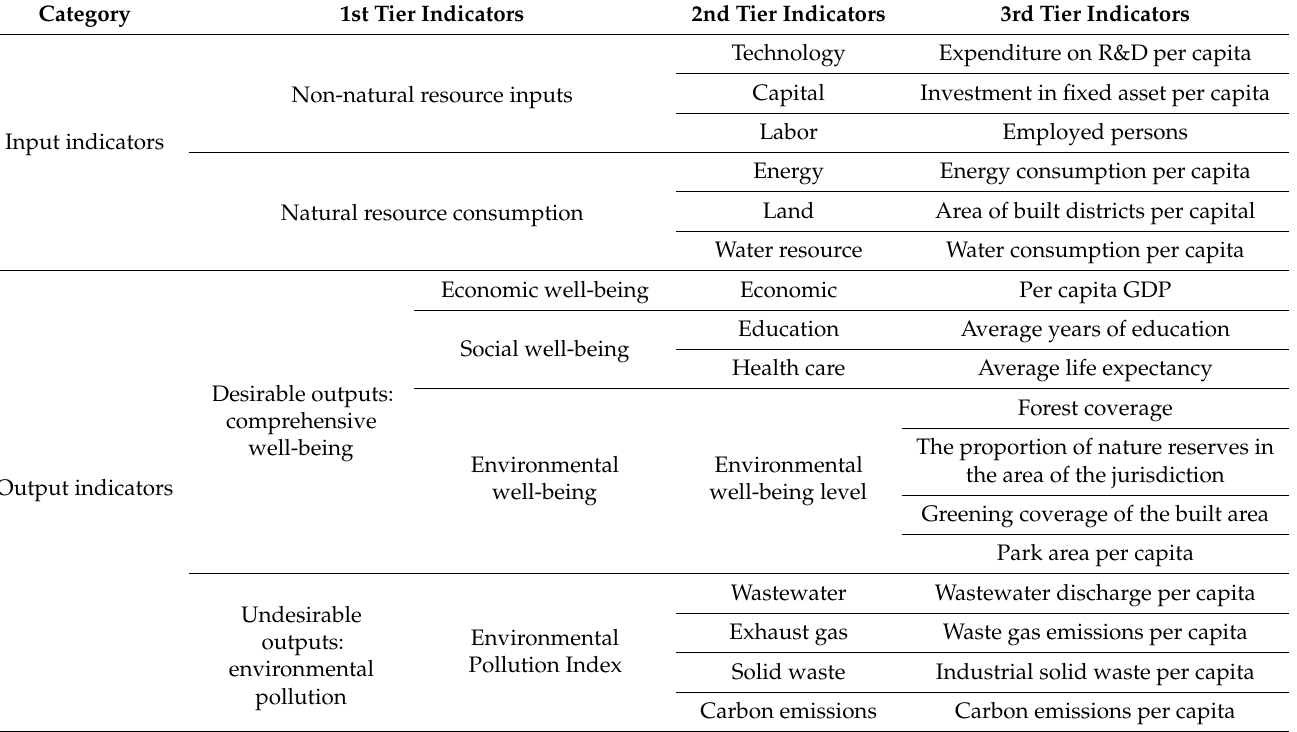
Table 3. Evaluation index system for ecological well-being performance. 1st Tier